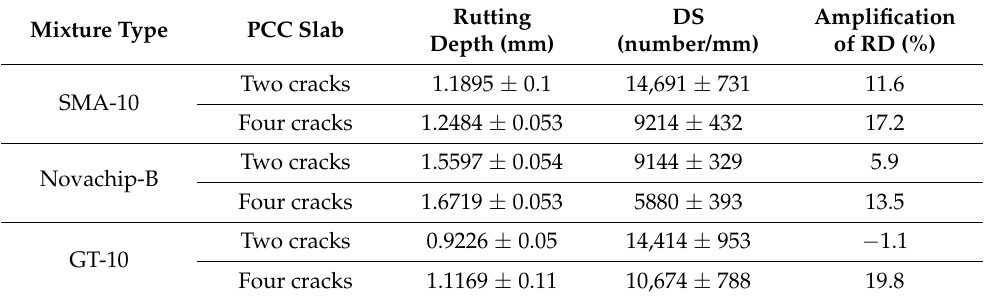
Table 9. The situation of composite specimens every 2 h.